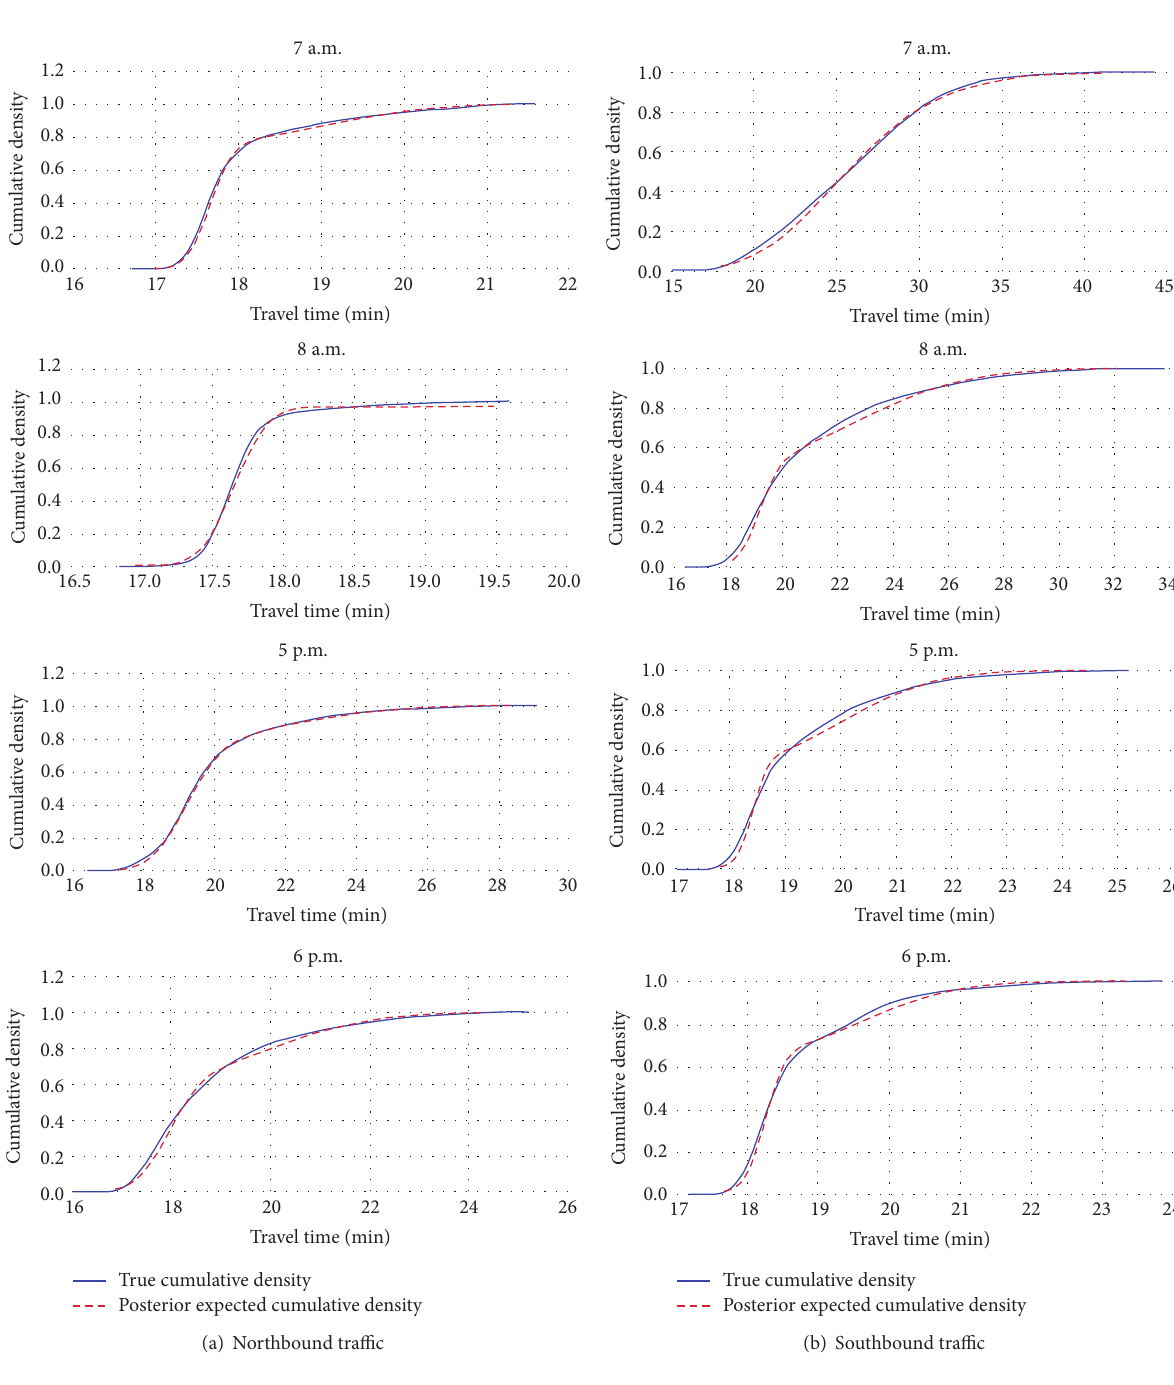
Figure 5: Cumulative predicted distribution and data cumulative